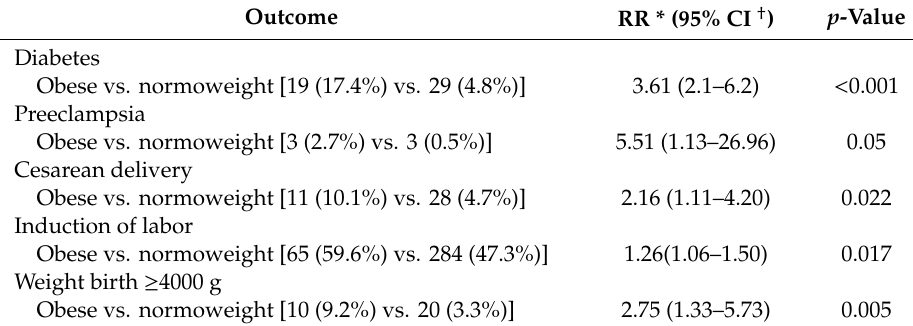
Table 2. E ff ects of maternal body mass index on pregnancy outcomes. Outcome